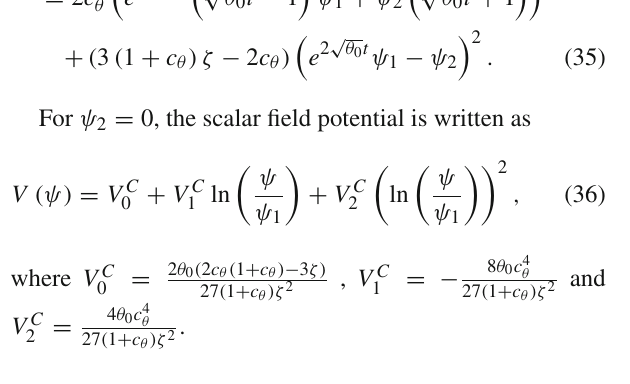
(cid:9) (cid:10) , 0 1 , dashed line is 2